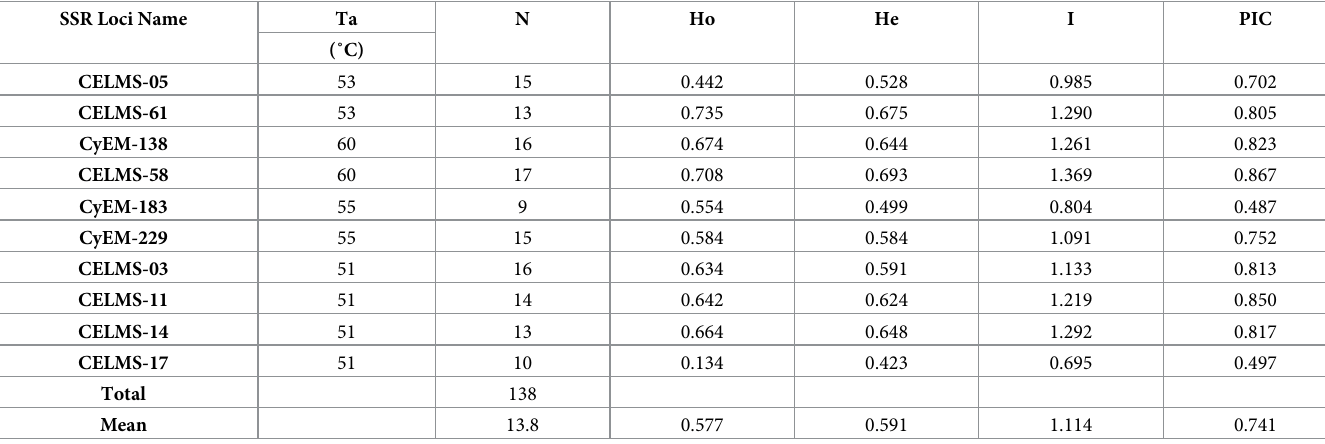
Table 2. Genetic parameters based on 10 Simple Sequence Repeat (SSR) loci and 121 Cynara cardunculus individuals. SSR Loci